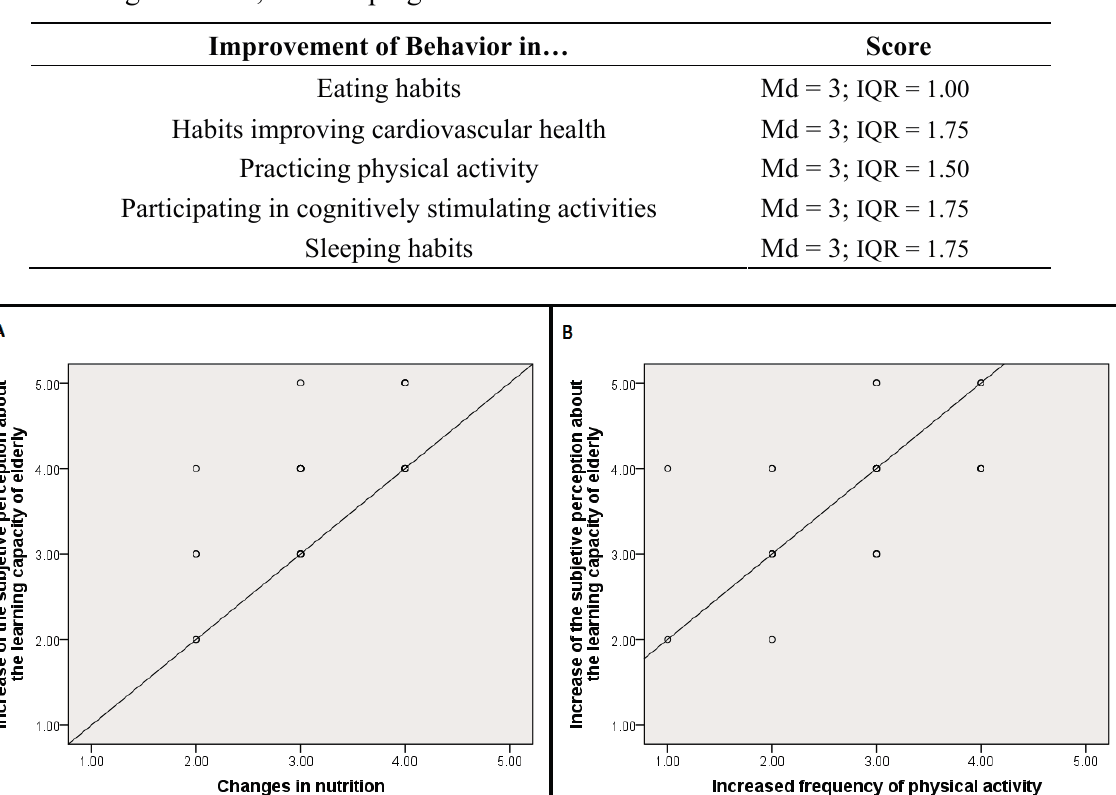
Table 3. Summary of Medians (Md) and Interquartile Ranges (IQR) of questions (5 point Likert-type scale, ranging from 1 = nothing to 5 = extremely) assessing the level of changes done in the following behaviors after attending the lectures: eating habits, habits improving cardiovascular health, practicing physical activity, participating in cognitively stimulating activities, and sleeping habits.